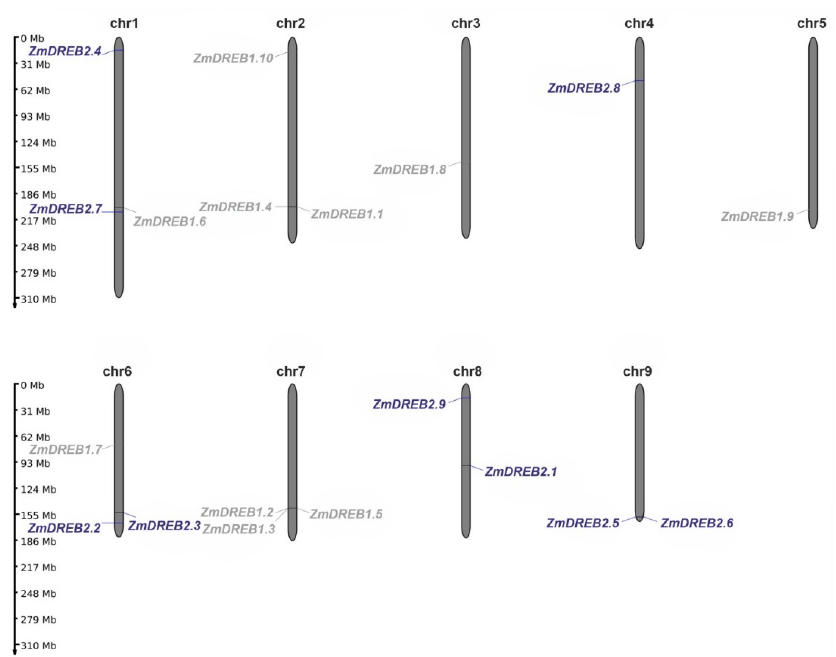
Figure 1. Chromosome location of A1-type ZmDREB1/2A (grey) and A2-type ZmDREB2.1/2A–2.9 (blue) genes in the Z. mays genome. Chromosome lengths (indicated on the left) are based on the Z. mays cv. B73 genome (Zm-B73-REFERENCE-NAM-5.0); chr, chromosome.